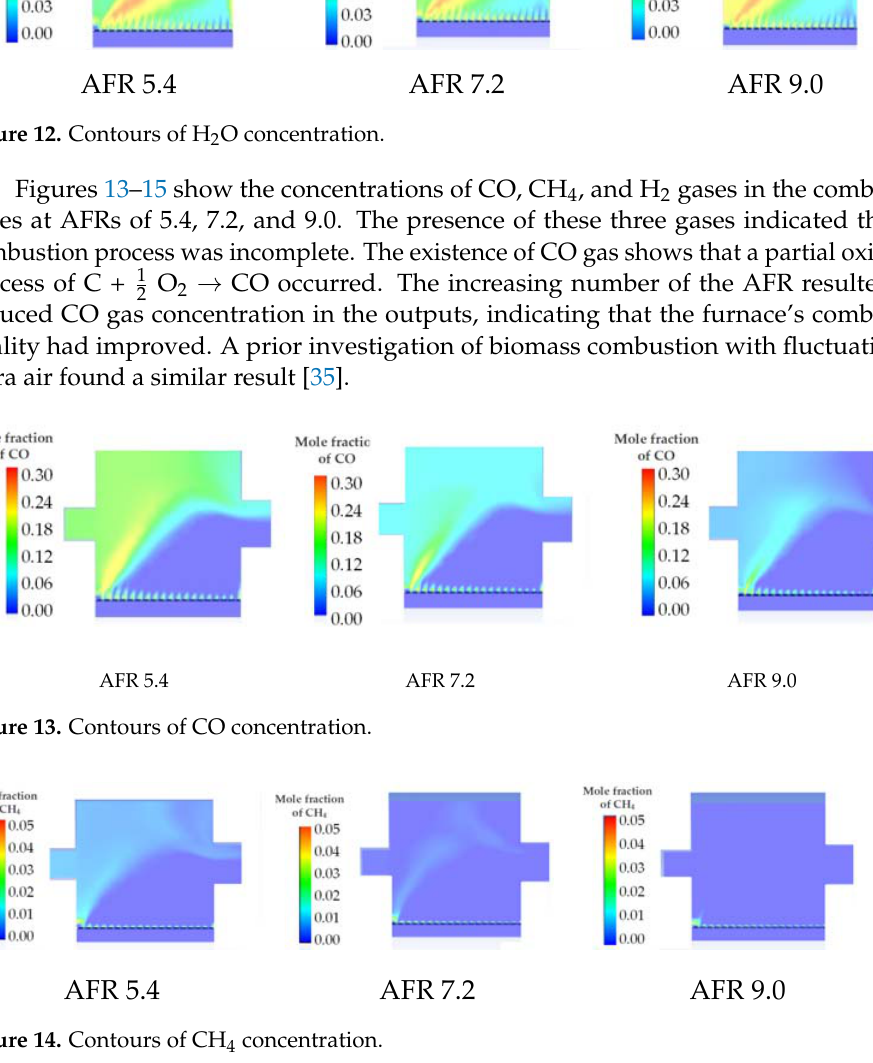
Figure 12. Contours of H 2 O concentration.